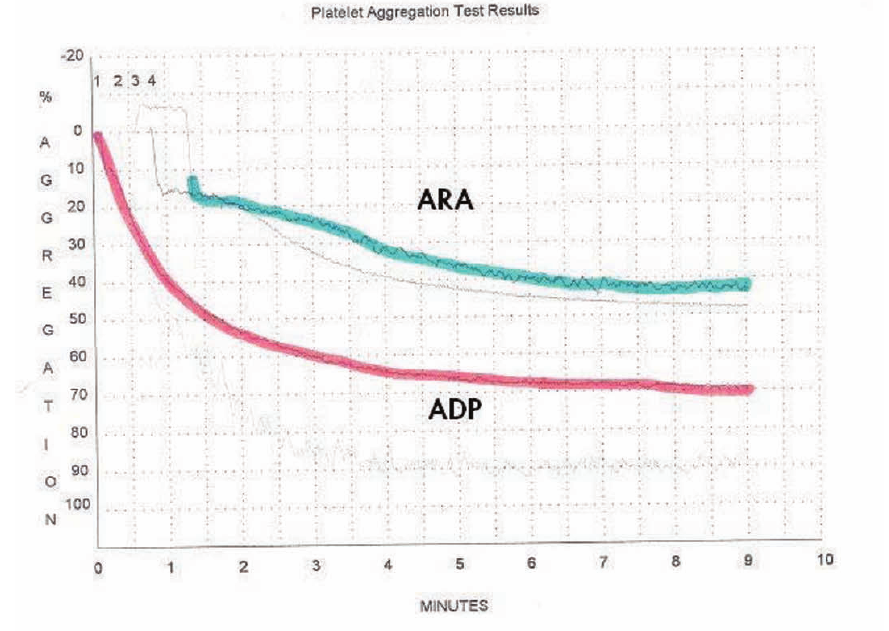
Figure 2. Light transmittance aggregometry (LTA) results for arachidonic acid (ARA) and 5-adenosine diphosphate (ADP)-like agonists of platelet aggregation. At that time the patient was treated with aspirin 100 mg and clopidogrel 75